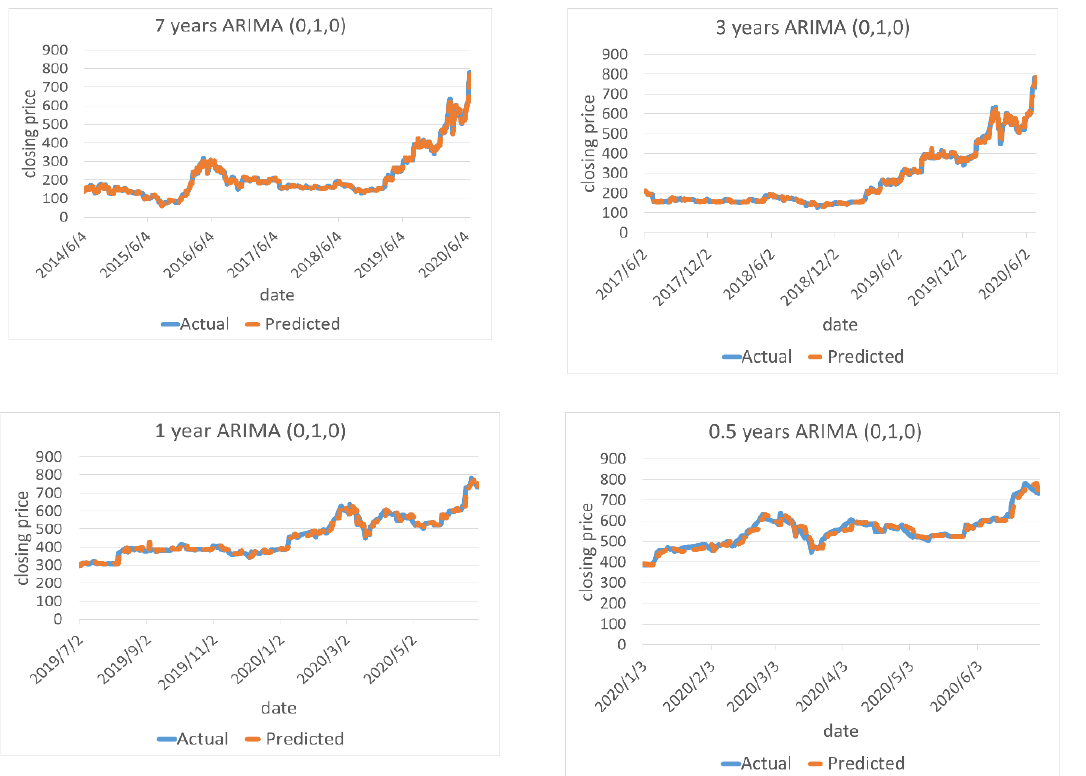
Figure 4. Prediction diagram of the optimal ARIMA model for 7, 3, 1, and 0.5 years for 3293 IGS. Table 6. Comparison of the optimal ARIMA models in different data intervals.